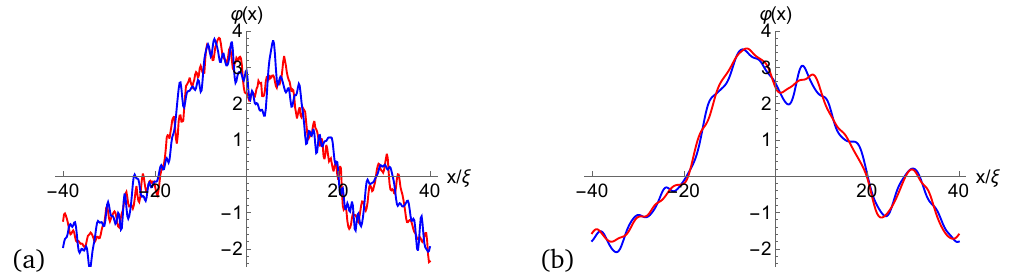
= 8ms, and for a different phase 1